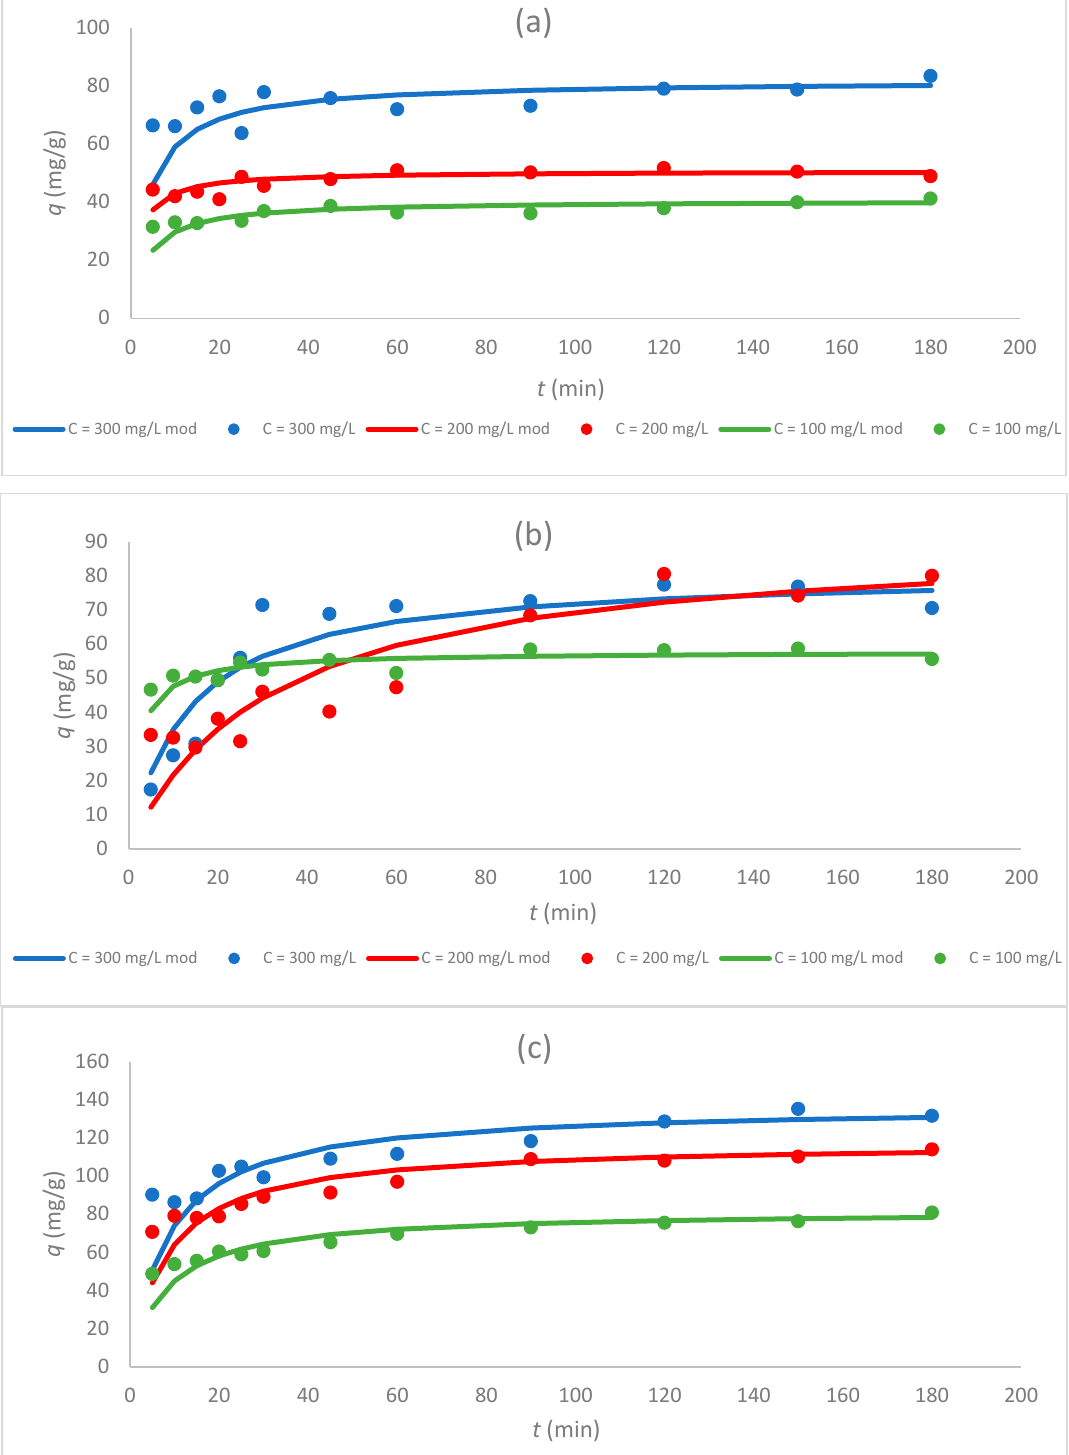
Figure 5. Dependence of the sorption capacity of the tested sorbents ( a ) Sargassum sp., ( b ) Sargassum sp. post-extraction residue, and ( c ) ZnO NPs on time for different pH values (3, 4, and 5; “mod”— model) at C 0 300 mg/L and C S 1.0 g/L.